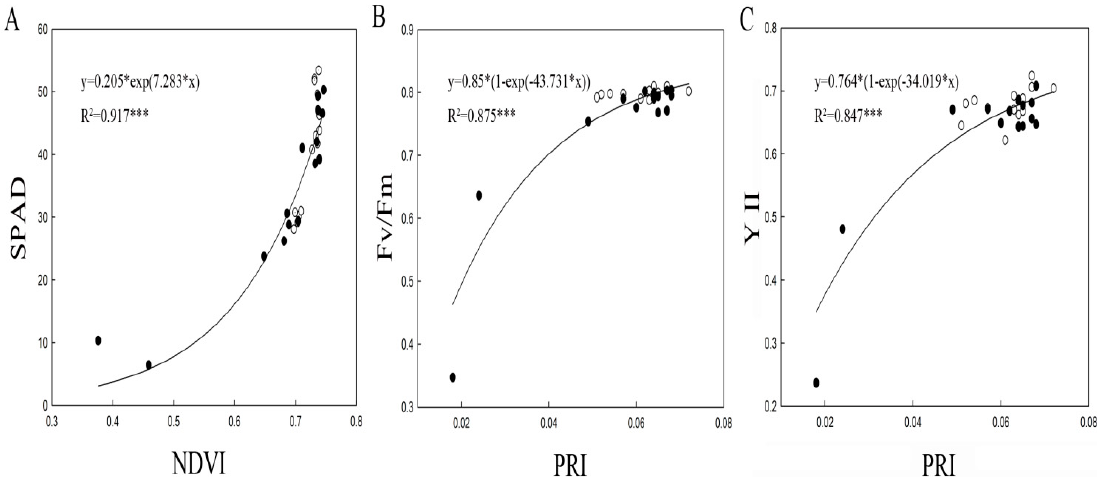
Di ff erent letters indicate significant di ff erence among various waterlogging treatments of all cultivars in each index ( p < 0.05). Each value is the mean of ten plants of each cultivar for C or W treatment. Data were collected at 0, 1, 3, 7, and 13 days of waterlogging treatment.